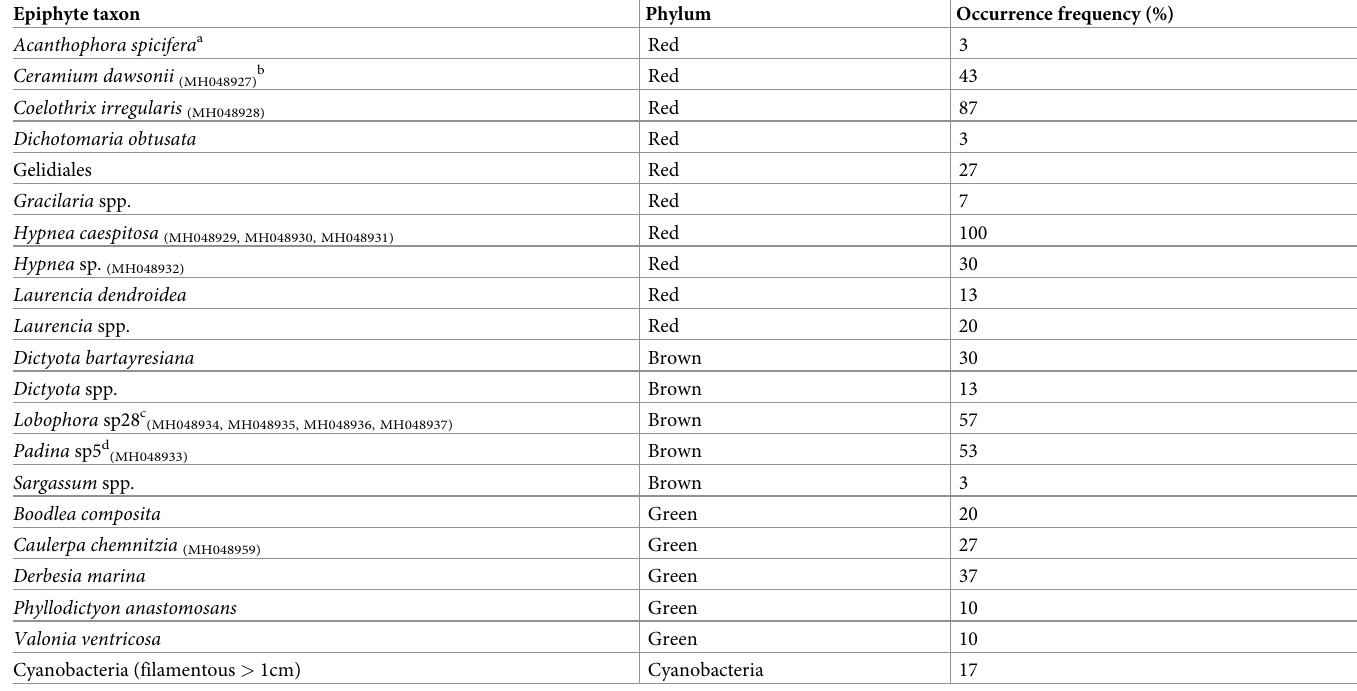
Table 1. Occurrence frequency (%) of epiphytic macroalgae on Galaxaura divaricata from the slope of site 7. Epiphyte taxon